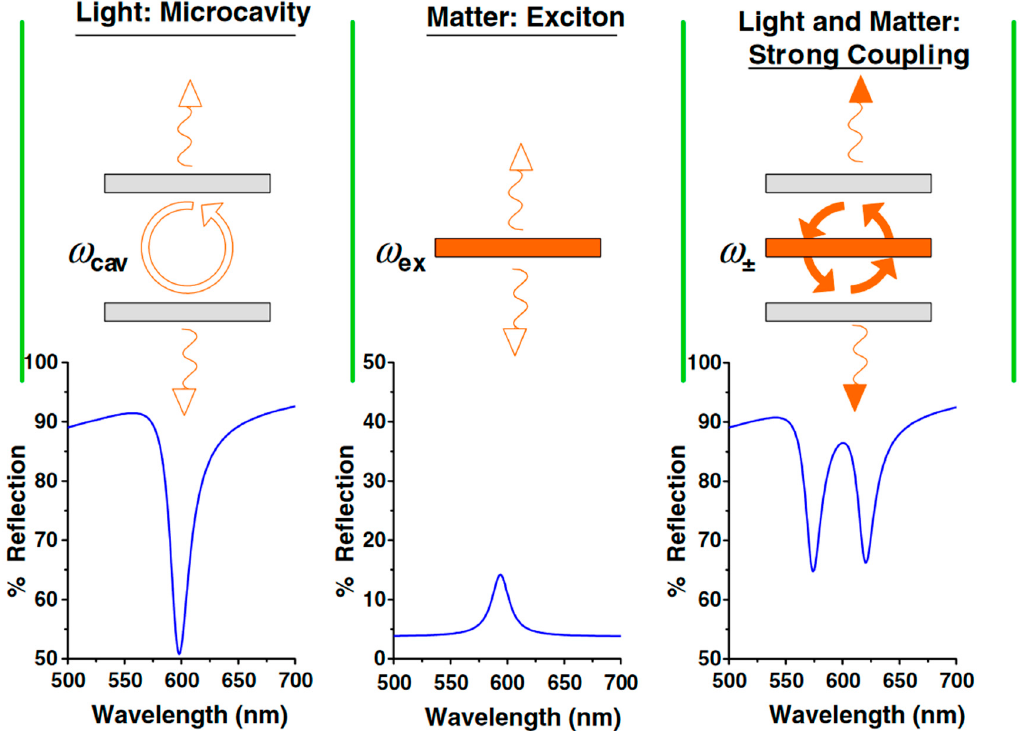
Figure 1. The mechanism of strong coupling between light and matter revealed by reflectance spectra [75].